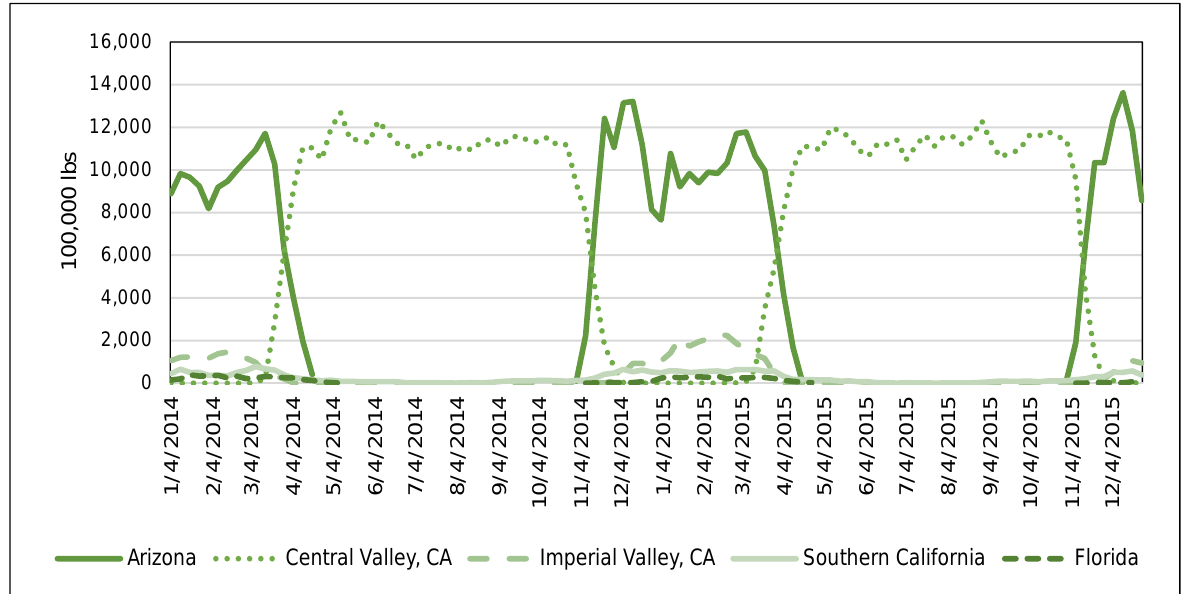
Figure 3. Weekly Lettuce Movements by Production Region,